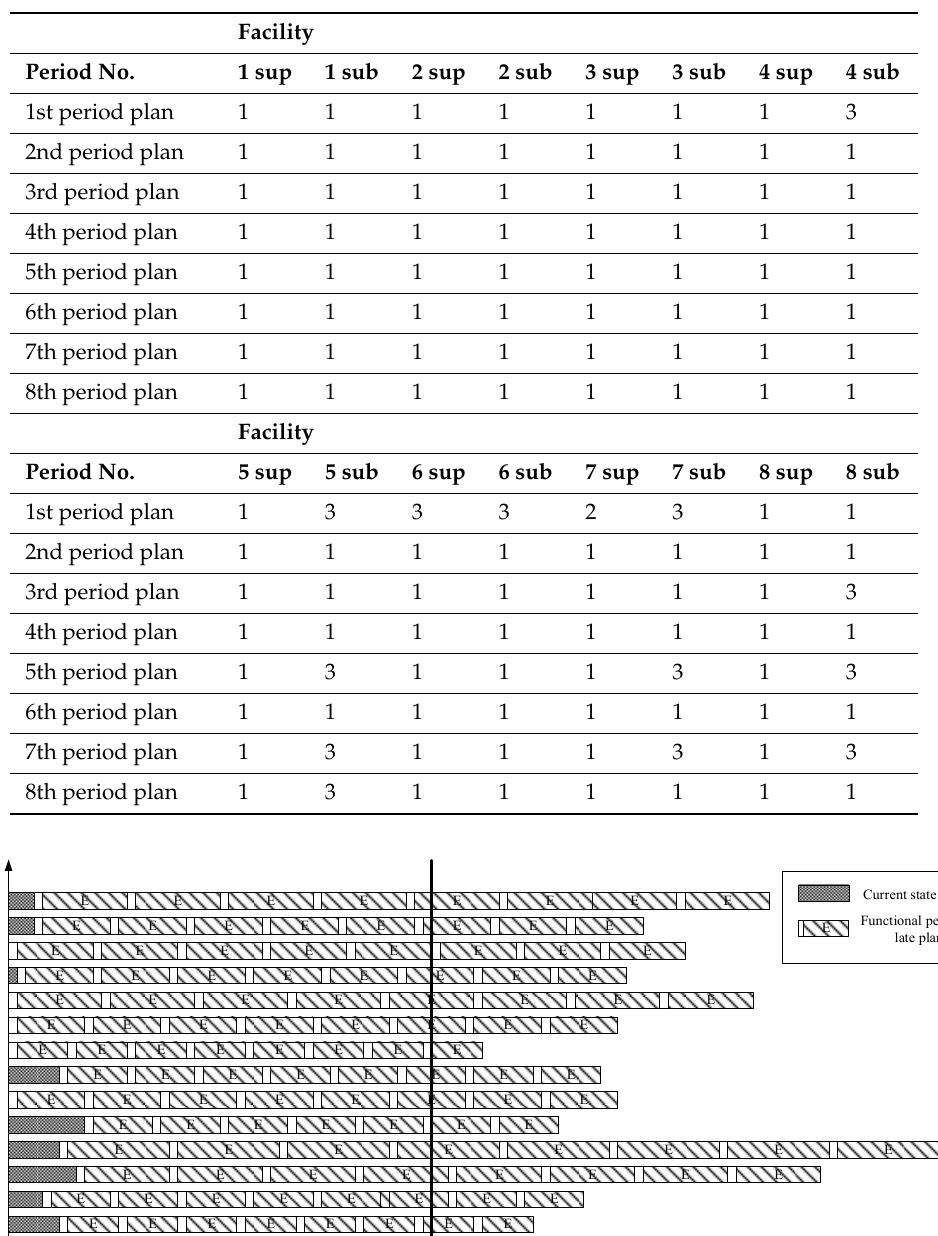
Table 9. Calculation results of Model-I.